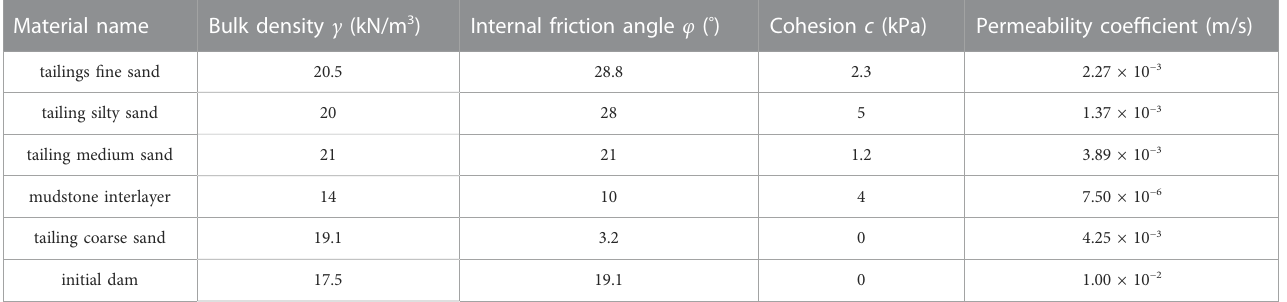
TABLE 1 Physical and mechanical parameters of tailing